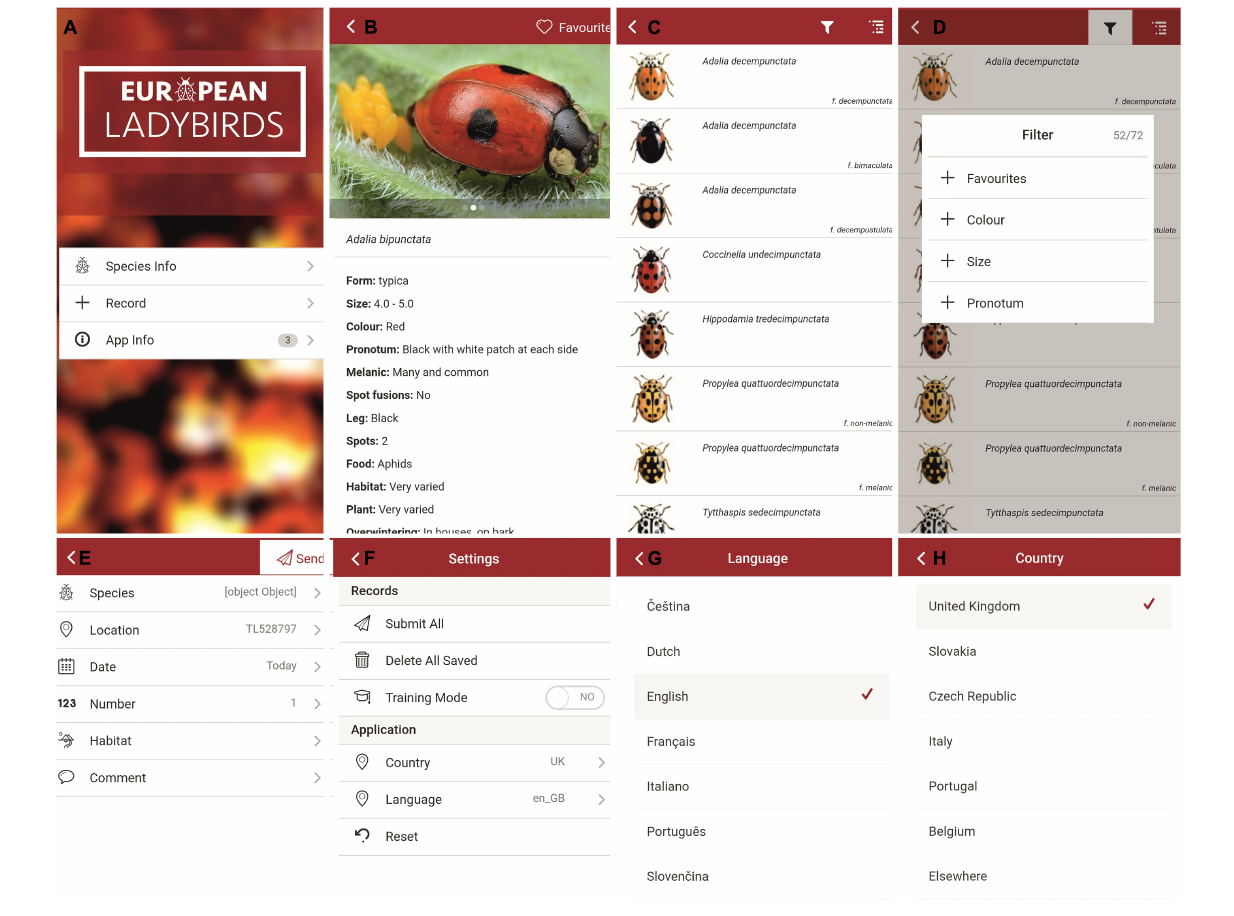
FIGURE 1 | Screenshots from the European Ladybirds smartphone application (app) used to record ladybird species, with Adalia bipunctata used as an example throughout. Records submitted are checked iRecord: (A) opening screen; (B) ladybird guide: providing identification information for the species selected, in this case Adalia bipunctata ; (C) ladybird guide: first screen, showing a list of species available to record, ranked by likelihood of occurrence; (D) ladybird guide: first screen, showing a list of species available to record, filtered by four traits of the ladybird; (E) adding a record: main recording screen once a species has been selected; (F) information: screen provides background information about the app; (G) information: screen provides for language selection; (H) information: screen provides for country